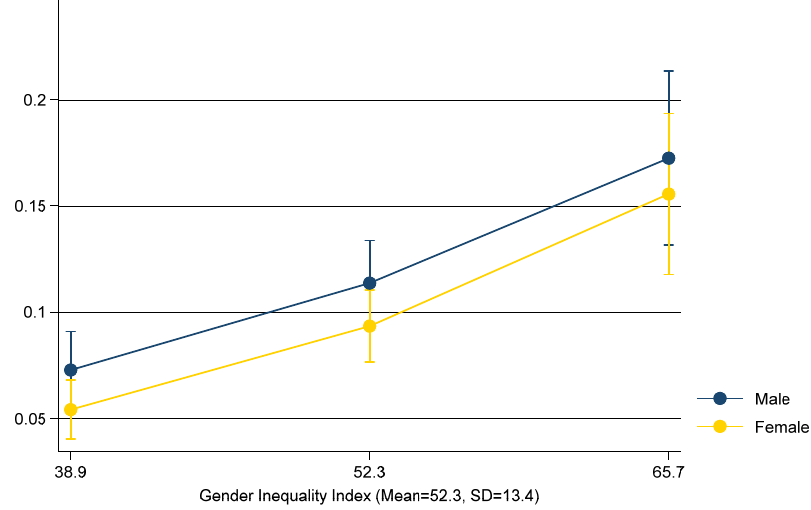
Figure 2. Predicted Probabilities of Caregiver Physical Abuse by Levels of GII.